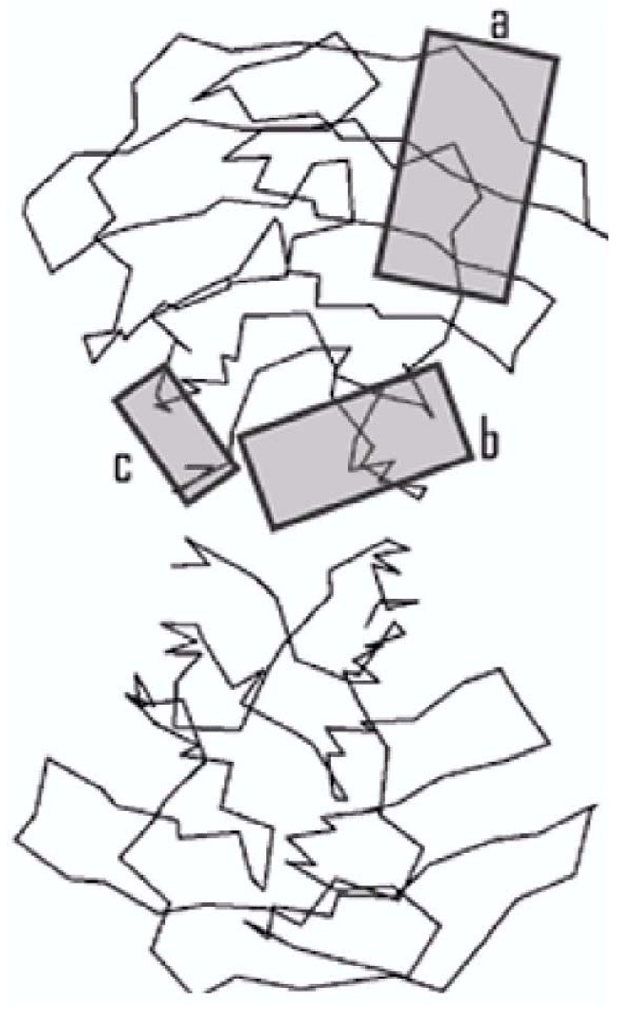
Figure 3 Location of Active Sites within the Galectin-1 Struc- ture This figure is adapted from one designed to show the three-dimensional structure of galectin-1 (Bourne et al., 1994). The three shaded boxes indicate regions involved in glycan binding (a), dimerisation (b), and cellular growth inhibi- tion